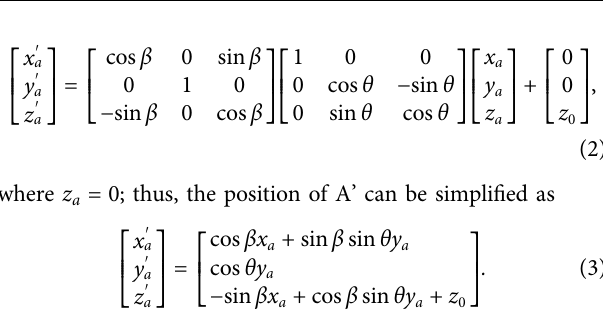
FIGURE 5 | The principle of actuation and control, (A) the brace can be considered as a parallel mechanism actuated by soft actuators; (B) a cascaded control strategy was used; (C) the dimensions of the actuation system are 24 cm*23 cm*6 cm and the weight is 1.76 kg.